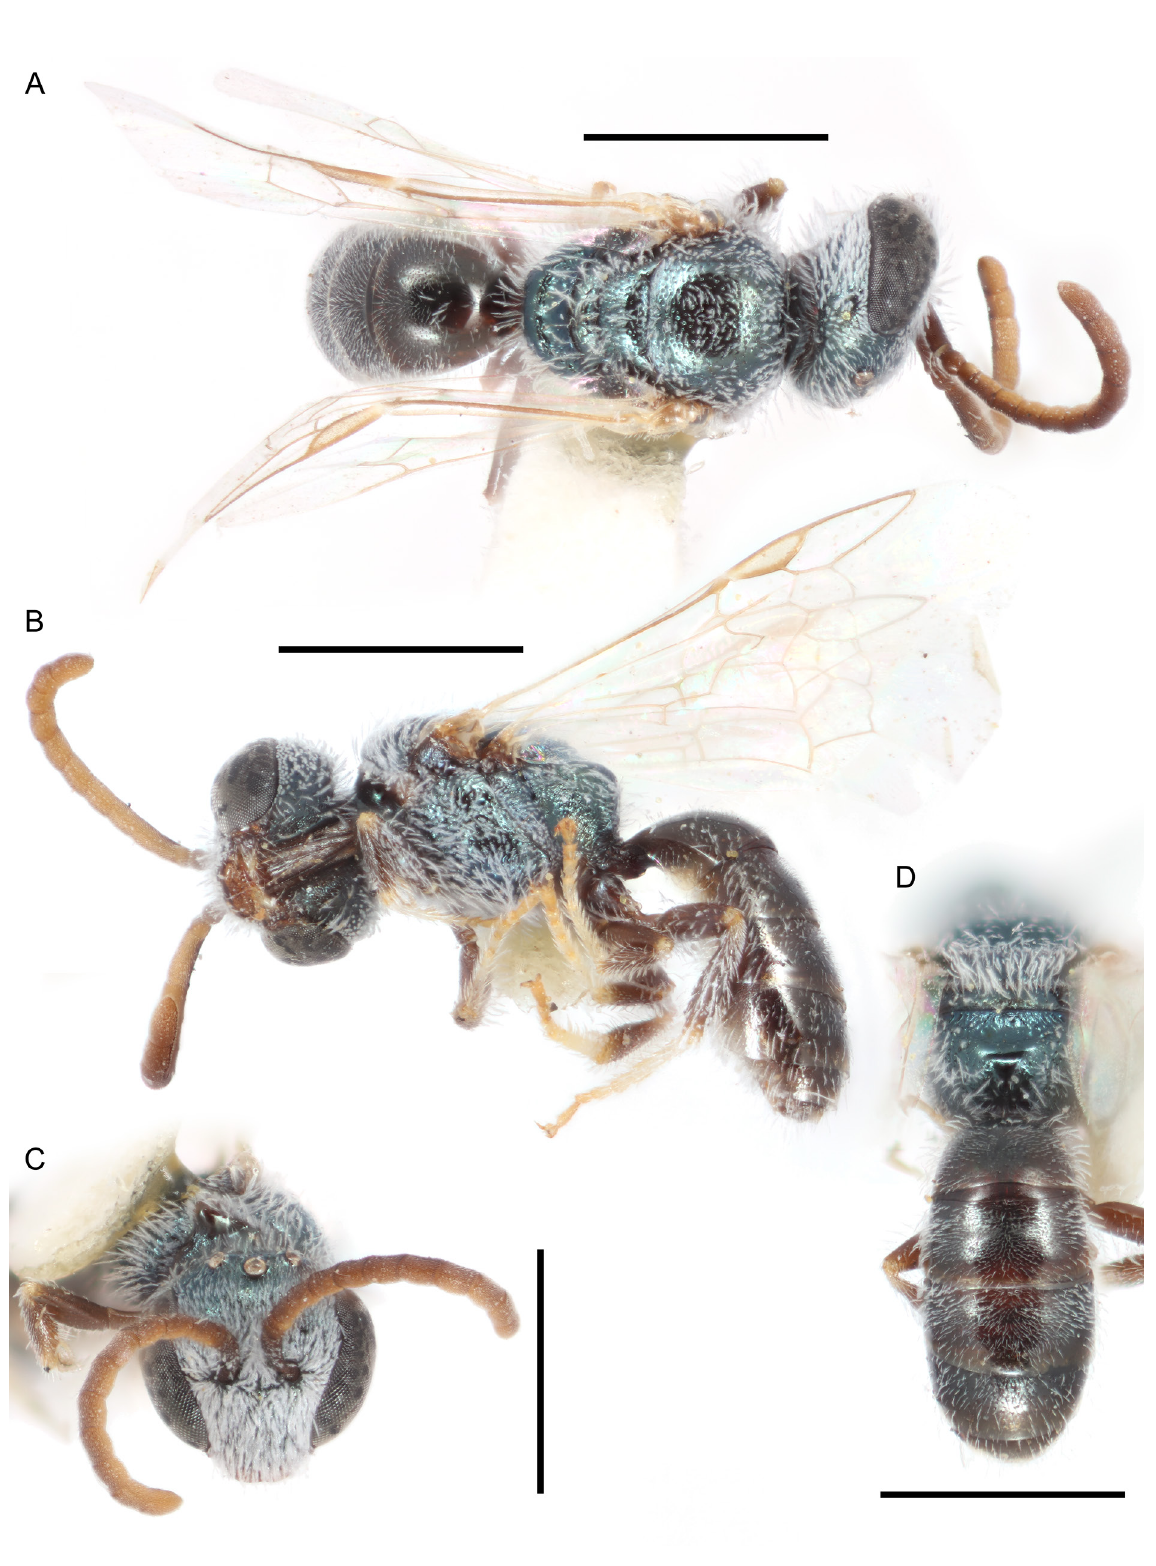
Fig. 71. Lasioglossum ( D. ) perditum sp. nov., ♂. A . Dorsal habitus. B . Lateral habitus. C . Face. D . Propodeum and metasoma. Scale bars: 1